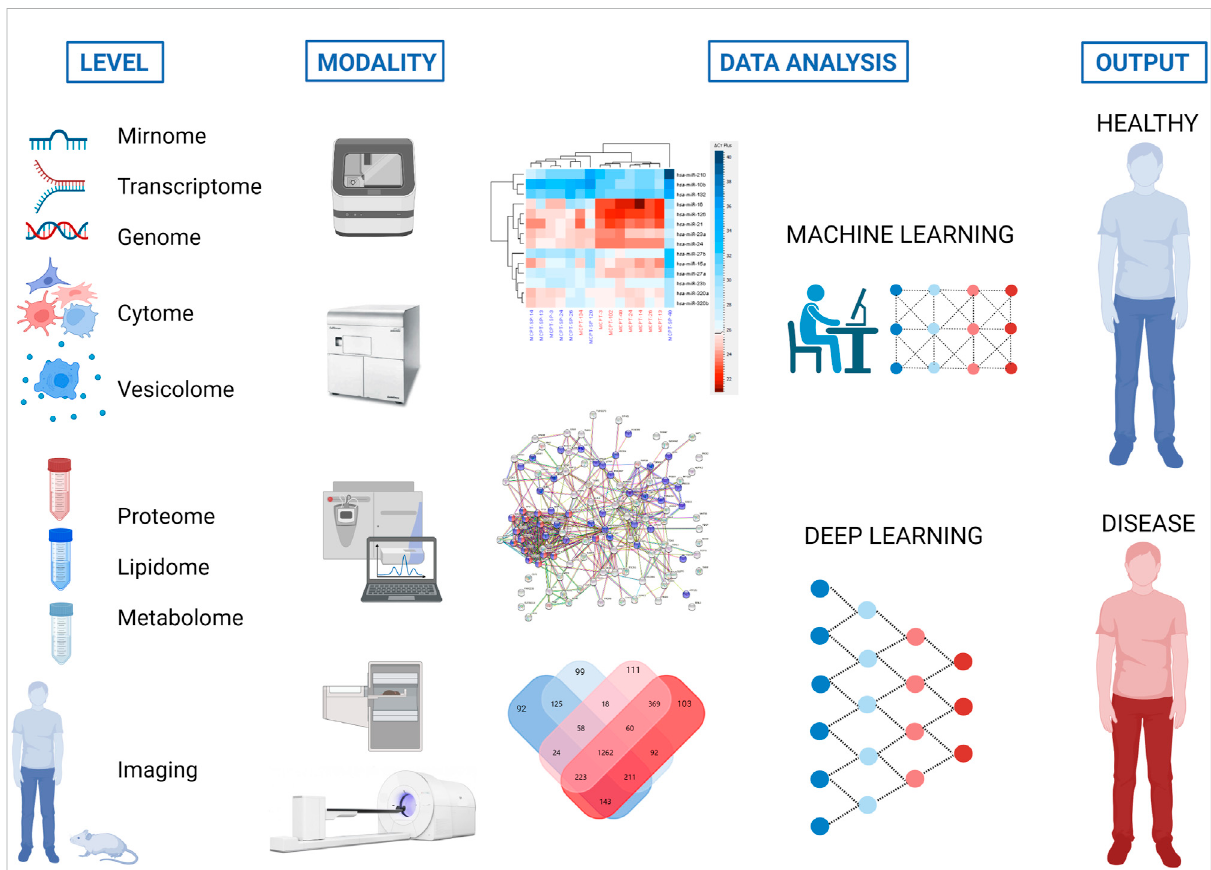
FIGURE 3 Strategy to use different omics and imaging modalities for characterization of extracellular vesicles ( EVs ) to de fi ne new biomarkers and therapeutic targets for disease recognition and treatment. The same tools for proteome, mirnome, genome, transcriptome, lipidome and metabolome analyses may serve for EV characterization (vesicolome). Created with